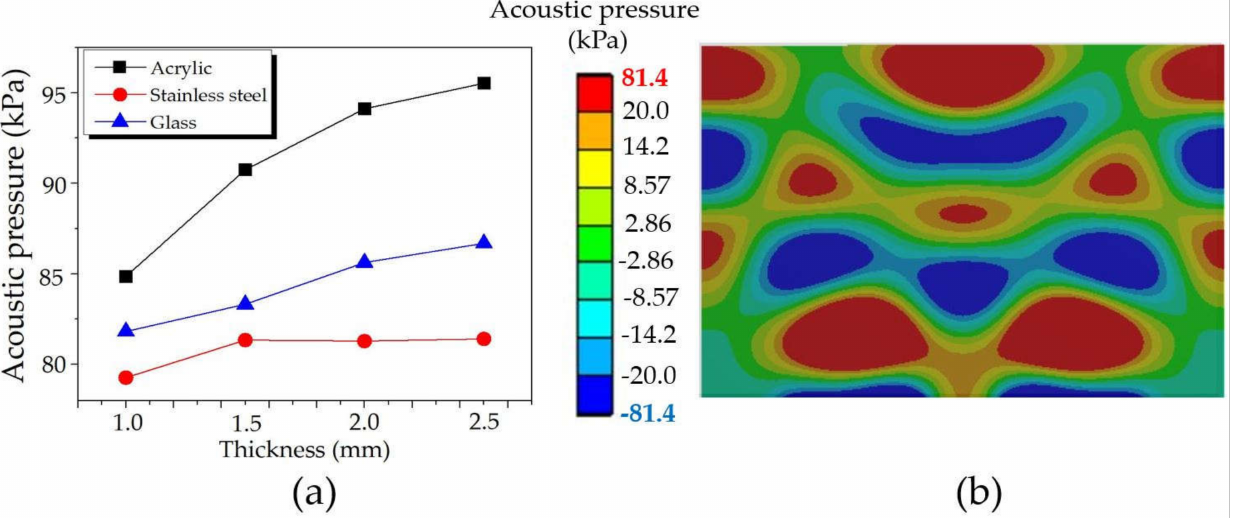
Figure 13. The maximum acoustic pressures: ( a ) comparison results for varying thickness and tank body materials, and ( b ) a sample of the distribution pattern of stainless steel with thickness of 2.5